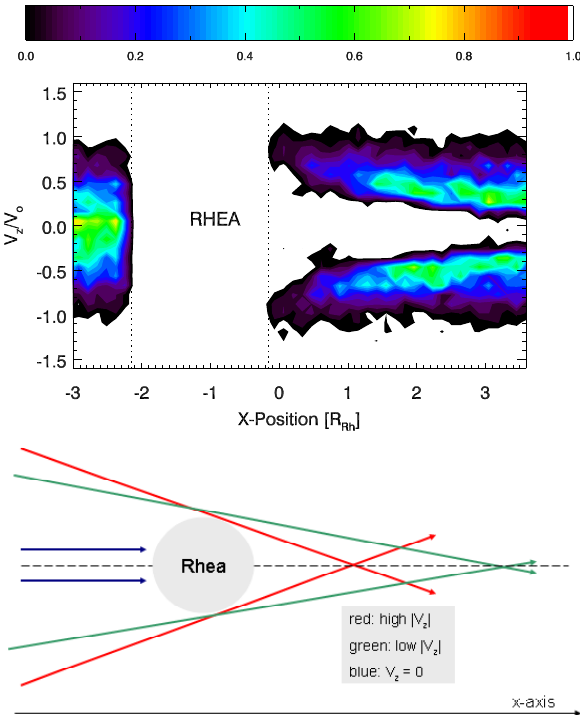
Fig. 14. (Top) Phase-space plot of V z along a hypothetical trajectory which is parallel to the x-axis and crosses Rhea through its center. The white region in the plot denotes the space occupied by Rhea’s volume. (Bottom) Sketch that explains the phase-space plot in the top panel. The dashed line shows the hypothetical trajectory along which the diagram of the top panel has been drawn.